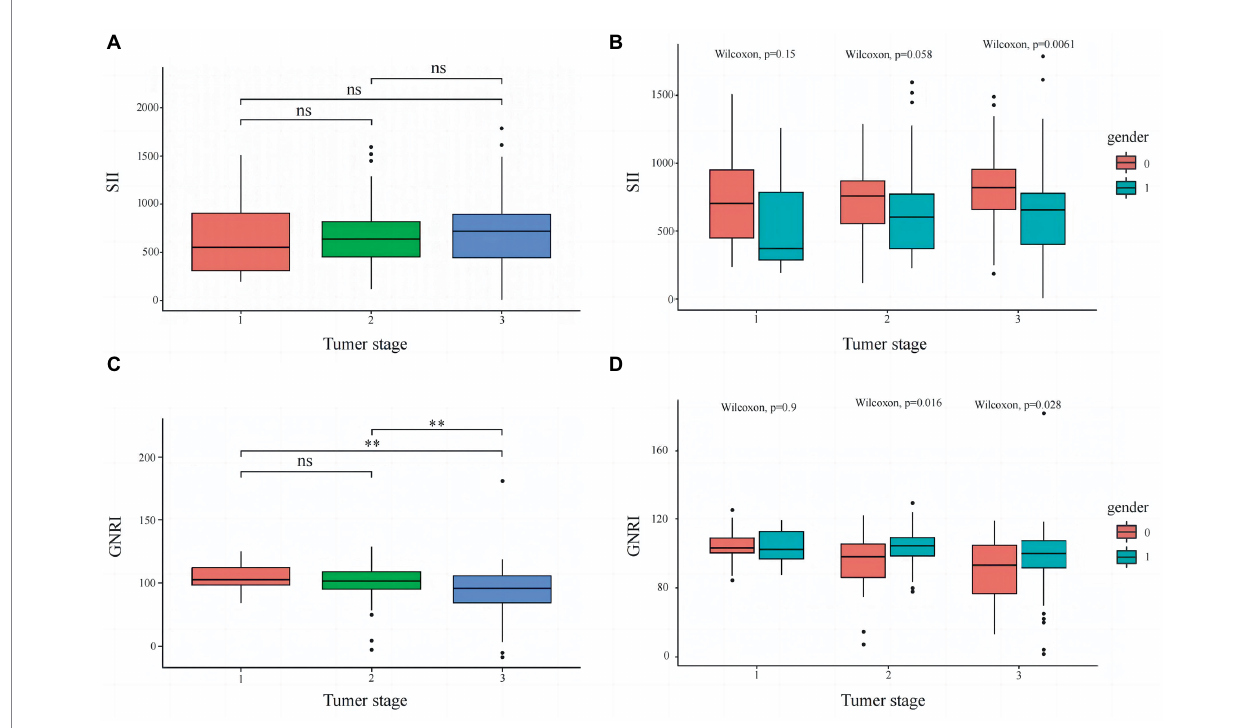
FIGURE 3 Distribution of SII and GNRI in different tumor stages. (A) SII in all patients, (B) SII in males and females, (C) GNRI in all patients, and (D) GNRI in males and females. ** p ≤